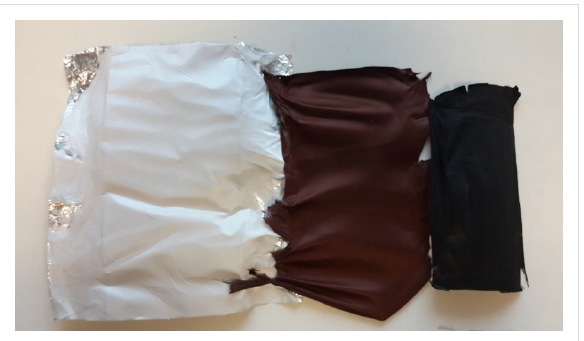
Figure 8: GO-containing PAN-based electrospun, oxidized and carbonized nanofibers.